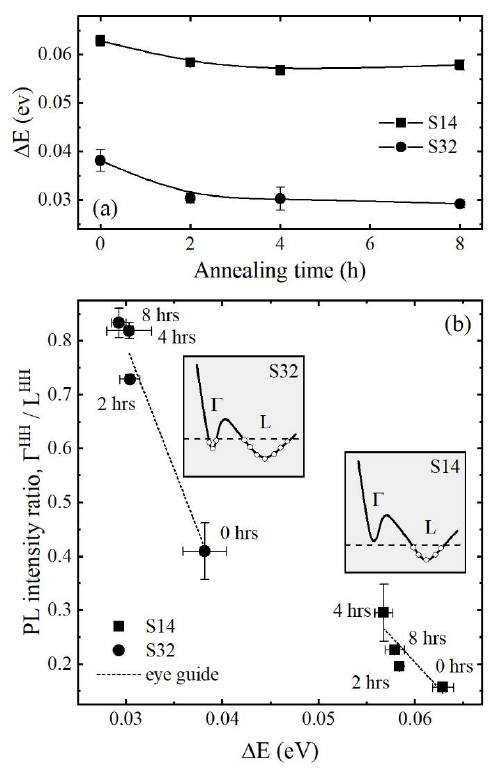
Figure 6. ( a ) The energy separation between Γ HH and L HH peaks on the measured PL and ( b ) the Γ HH /L HH intensity ratio. To confirm our understanding, temperature dependent PL measurements were per- formed to examine the relative peak intensity of direct (Γ HH ) and indirect (L HH ) transitions as a function of temperature (Figure 7). A red shift of both Γ HH and L HH peaks is seen with increasing temperature, which agrees with the bandgap shrinkage [24,25]. The peak in- tensities and their positions were determined again by fitting each measured spectrum with two Gaussian functions. However, due to the reduced PL intensity with increasing temperature, the Γ HH and L HH peaks were not resolved on the spectra measured above 200 K.